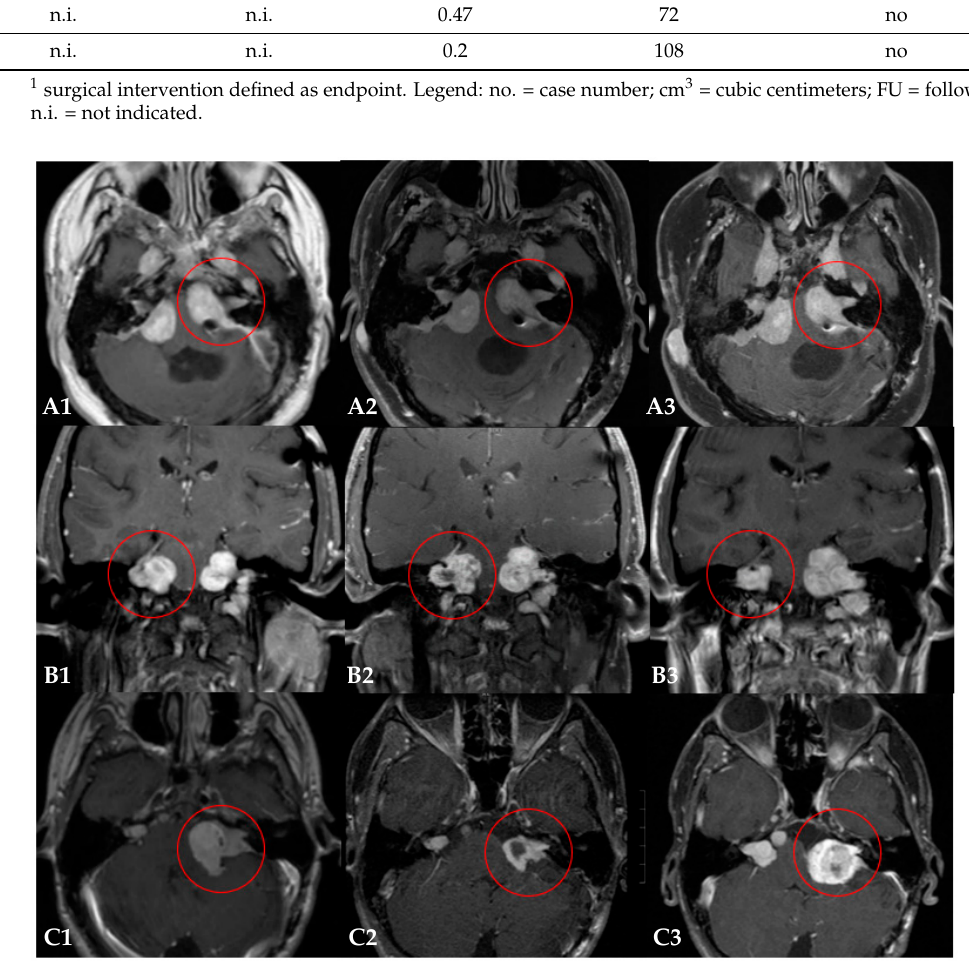
Figure 1. Three examples of the radiological follow-up of Neurofibromatosis Type 2-related vestibular schwannomas treated with proton radiotherapy (PRT). Each row ( A – C ) represents MR imaging of one patient over time: the baseline MR image ( 1 ), the MR image one year after PRT ( 2 ), and the most recent MR image ( 3 ). Patient ( A ): the tumor of interest remained stable during the follow-up of 60 months ( A1 – A3 ). Patient ( B ): the initial tumor shrinkage achieved with PRT and adjuvant bevacizumab therapy ( B1 ), was followed by tumor progression ( B2 ) that required additional treatments with bevacizumab (B3). Patient ( C ): the initial tumor shrinkage (C1–C2) was followed by sig- ni fi cant tumor progression (C3), requiring salvage surgery at 87 months after PRT. Two patients (25%) required additional treatment for tumor progression of the irra- diated lesion. In patient #5, adjuvant bevacizumab therapy was required after the PRT,